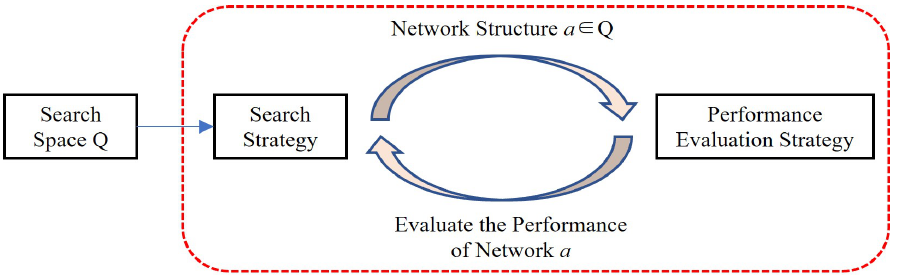
Figure 1. Model structure of NAS. With a search space Q in the search strategy, the performance of network a is continuously evaluated through the search strategy to find the optimal neural network structure.